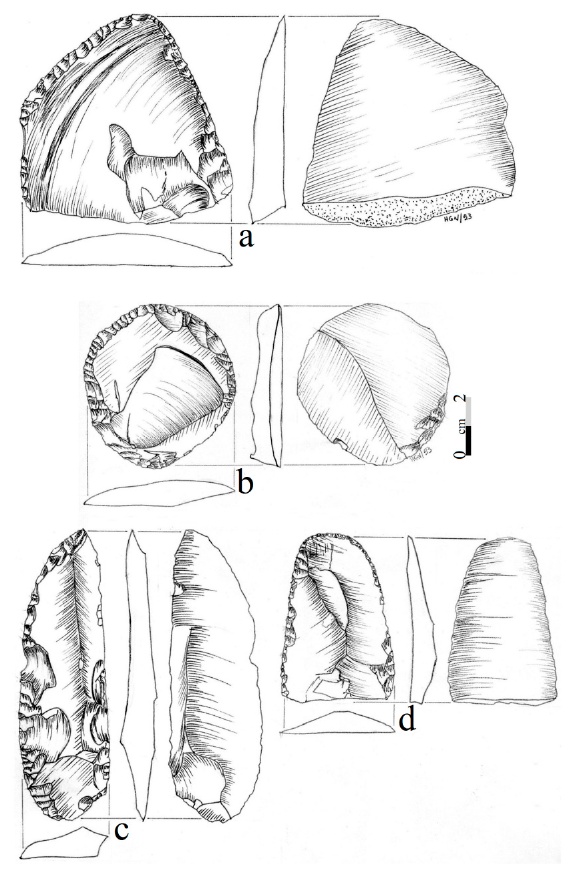
Figure 15. Unifacial tools coming from the Paleo-american level of CM. Depictions ( a–d ) are given in text and Table 2.